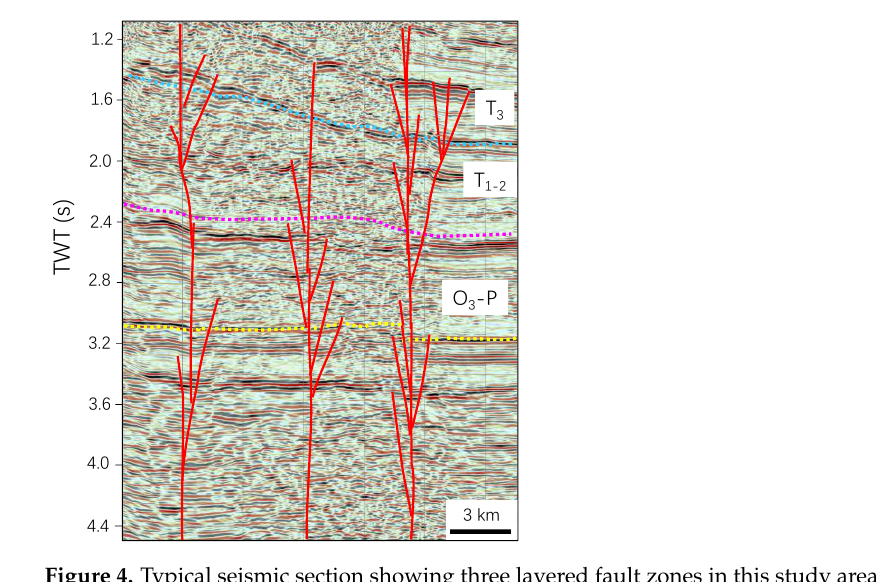
Figure 5. The strike-slip fault distribution in the Triassic of this study area.